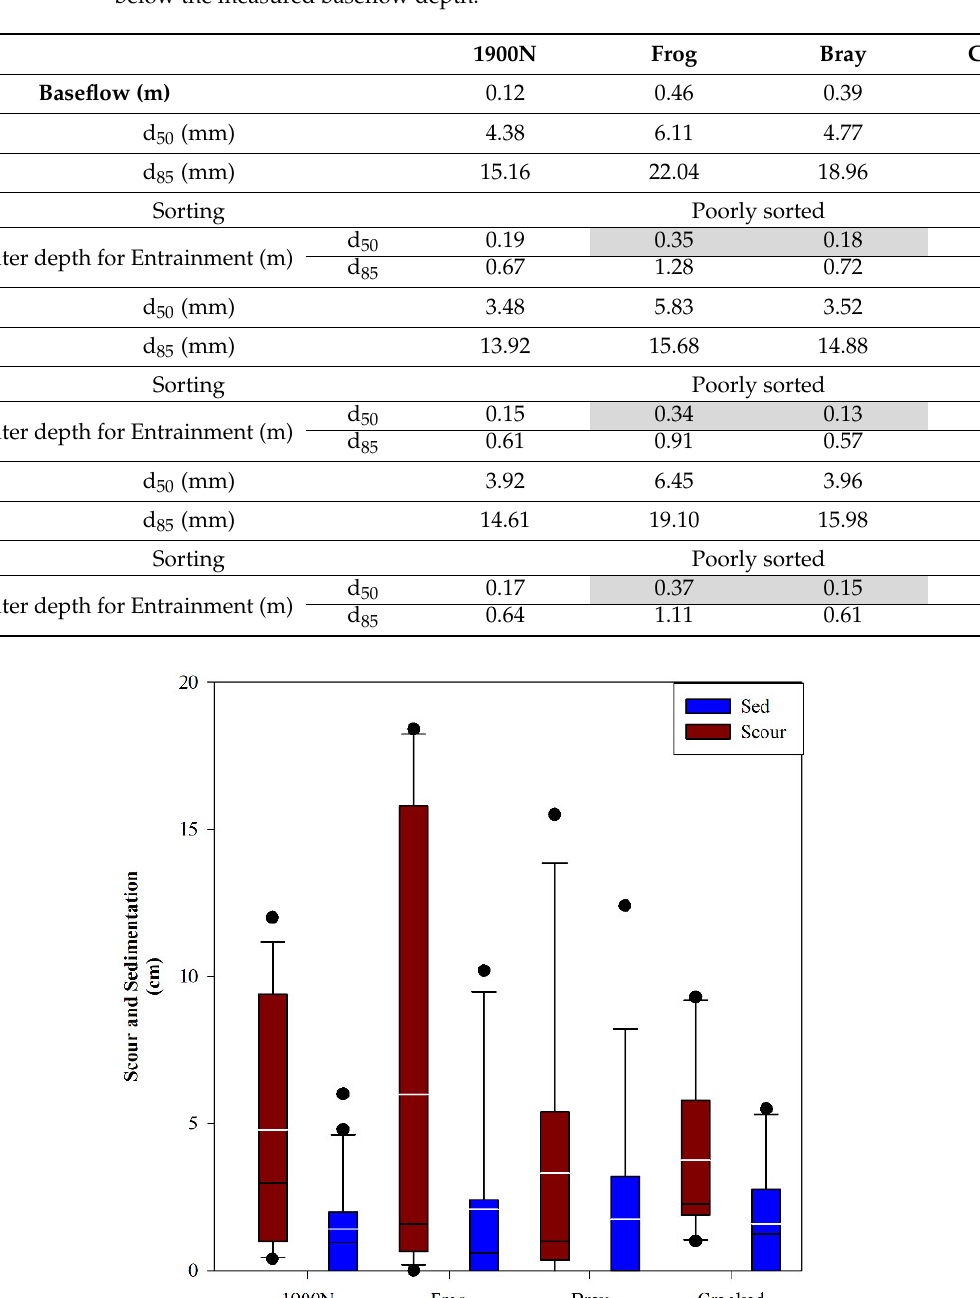
Figure 8. Cumulative percent organic matter in sediment less than 1 mm in diameter collected dur ‐ ing the fall and spring.